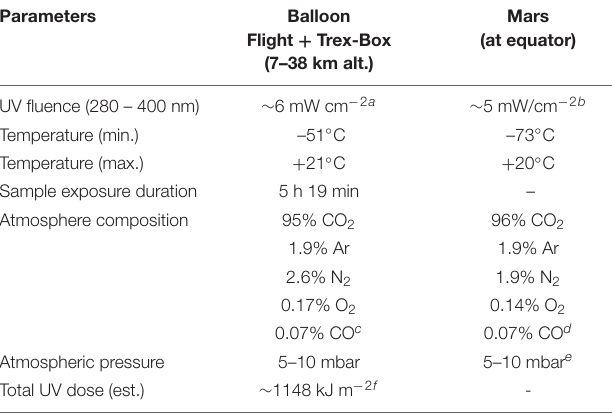
TABLE 3 | Environmental conditions aboard balloon flight compared to martian conditions. Parameters Balloon Flight +